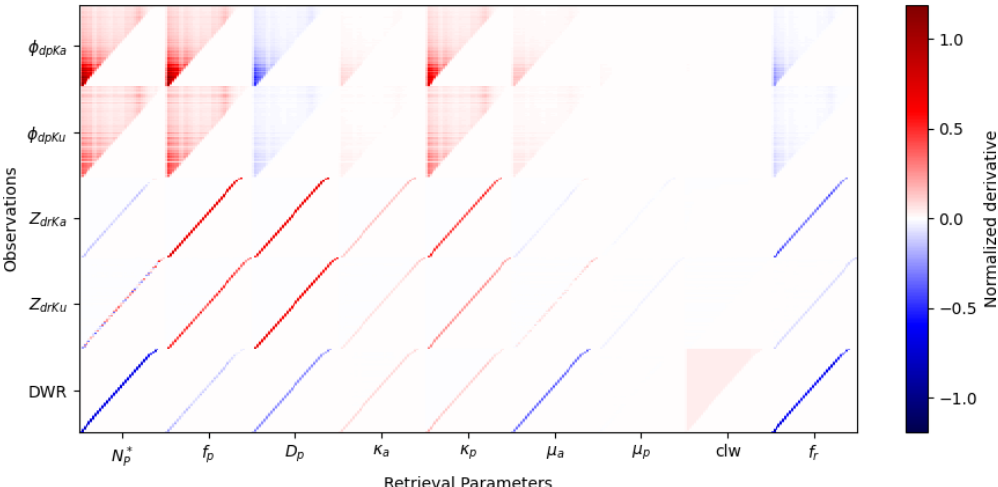
Figure 8. Jacobian matrix of partial derivatives of the simulated D3R measurements to the retrieval parameters. The partial derivatives have been normalized element wise by the square root corresponding diagonal element of S y – i.e., the expected standard deviation of that measurement’s error.